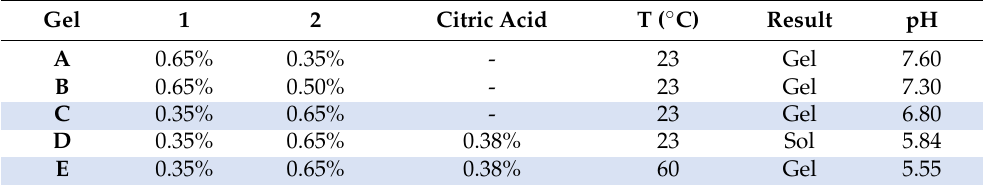
Table 1. Summary of the hydrogels containing peptides 1 and 2 . The % are expressed as w/V.